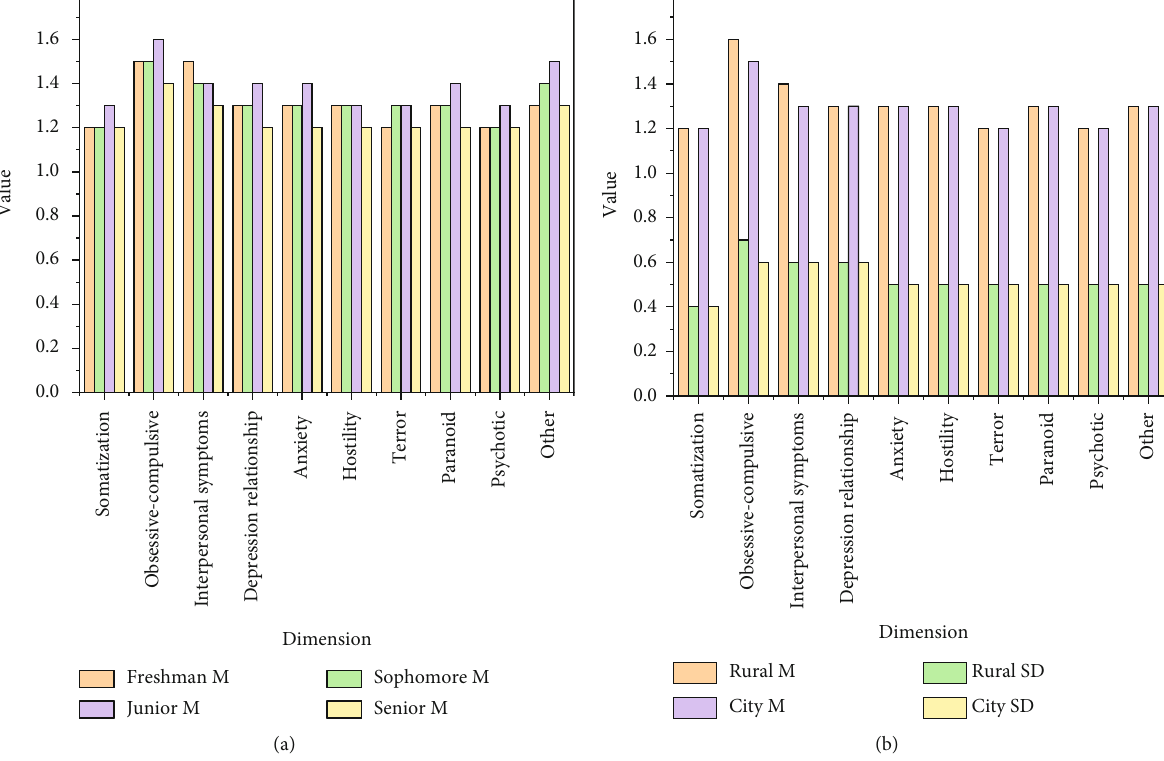
Figure 6: Results of the survey on the di ff erences between grades and places of origin ((a) grade di ff erences; (b) di ff erences of students ’